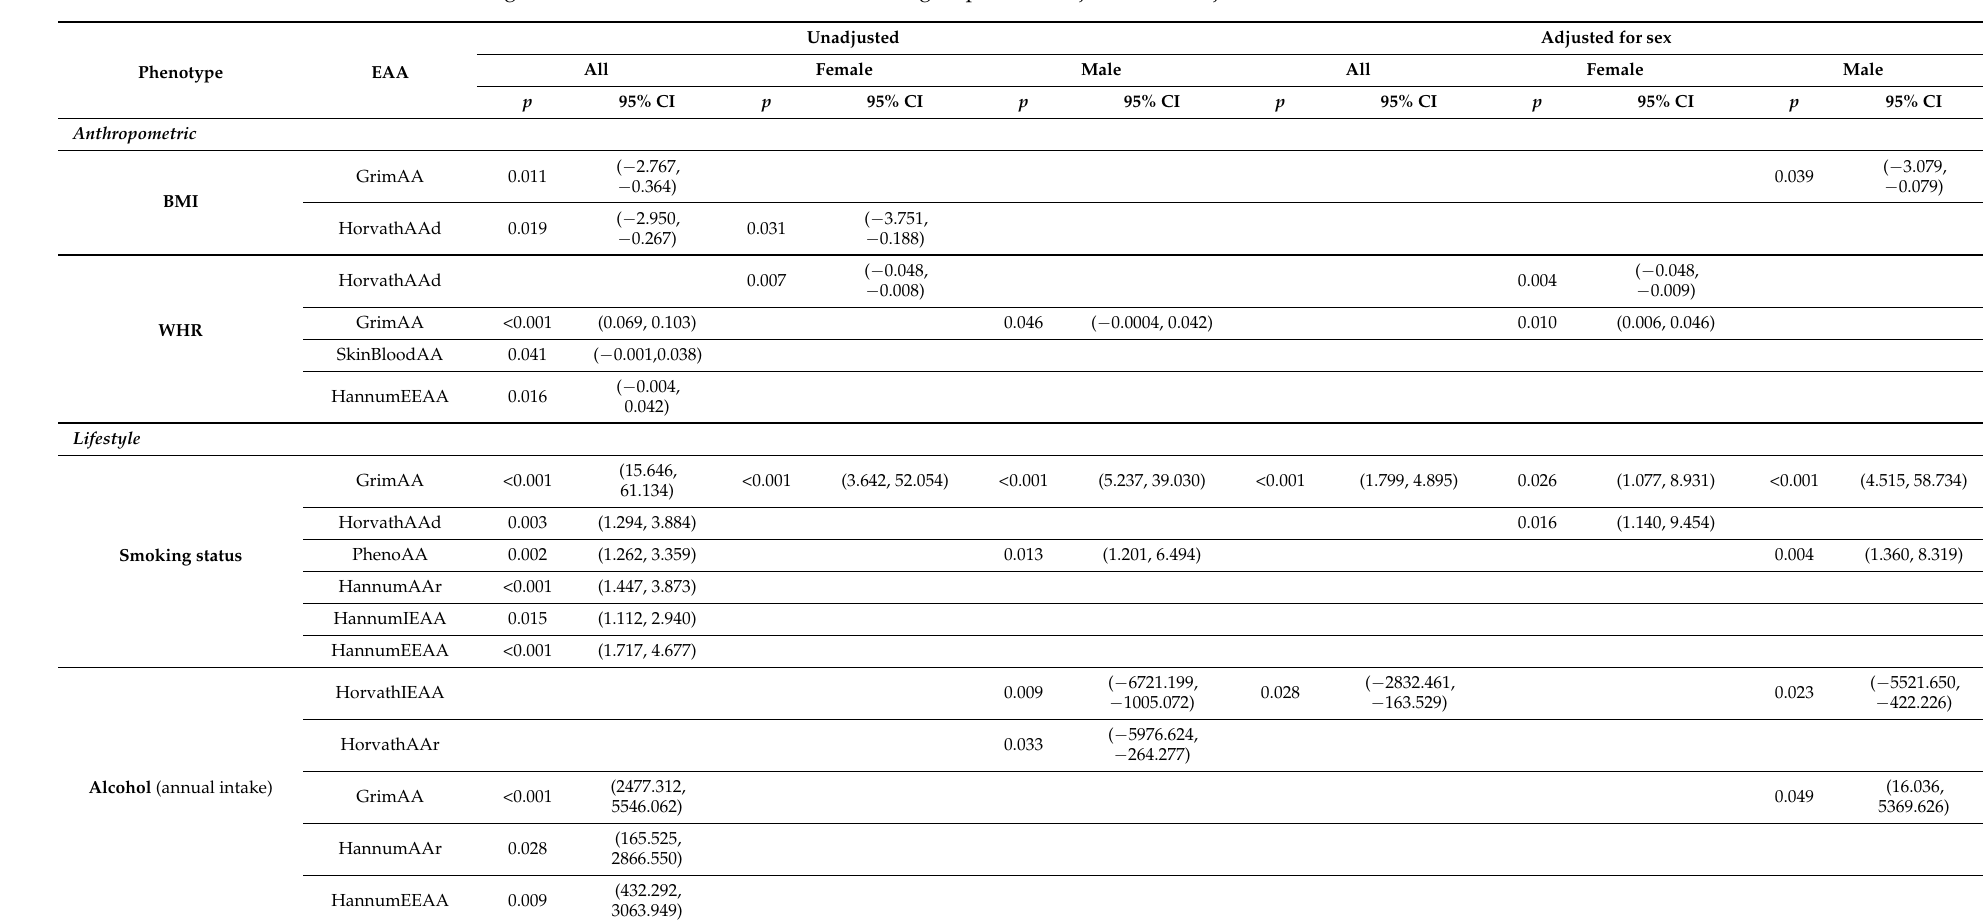
Table A5. Significant differences in EAA − and EAA + groups for unadjusted and adjusted for sex EAA